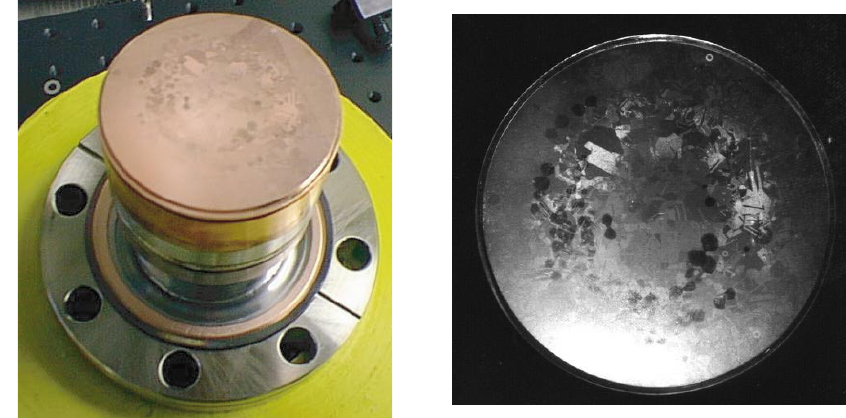
FIG. 16. (Color) Picture of one end cap from the first high-power test. A change in the crystal grains is visible even in the region where the temperature rise was lower by 10%. The region of the end cap nearest the high-power coupler is on the lower left in the right-hand picture. Tarnish from the sputtering of copper is on the lower part of the end